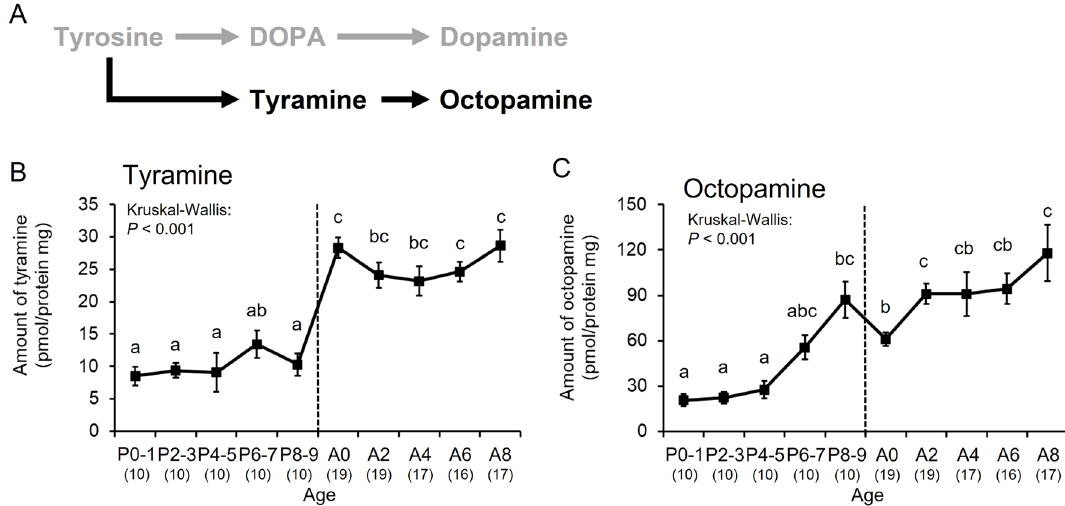
Figure 2. Age-dependent changes in octopamine-related substances normalized by brain protein in bumble bee males. ( A ) Synthetic pathway for octopamine-related substances. Levels are shown of tyramine ( B ) and octopamine ( C ). Error bars indicate standard errors. Significant differences according to the Steel–Dwass test ( P < 0.05) are indicated by different letters. Sample sizes are shown in